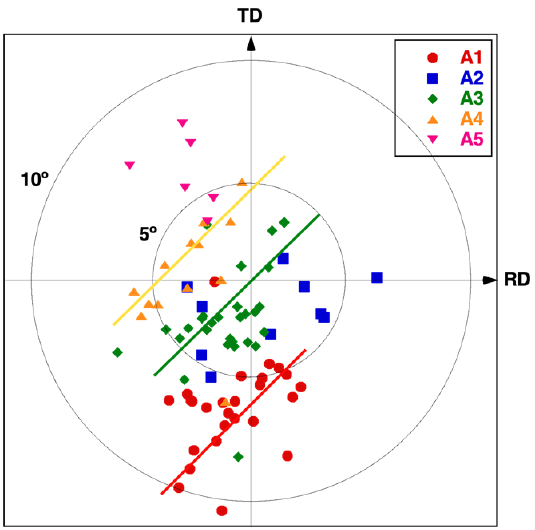
Figure 12. Correlation between the grain orientation before laser irradiation and the laser-generated nanostructures and microstructures (types A1 to A5) on Ni5W tape. Each point represents a grain. Its position in the plot is given by the stereographic projection of the grain orientation prior to laser irradiation, whereas the used symbol corresponds to the laser-generated structure (type A1 to A5) in this particular grain (see further explanation in the text and in Figure S3). RD and TD refer to the rolling direction and transversal direction, respectively. Circumferences indicate specific misorienta- tion angles of 5 ◦ and 10 ◦ with respect to the surface normal direction (ND, i.e., 0 ◦ represented by the origin). The straight lines guide the eye and correspond to preferential orientation trends of grains where different type of structures (A4, A3 or A1 (from top to bottom)) are